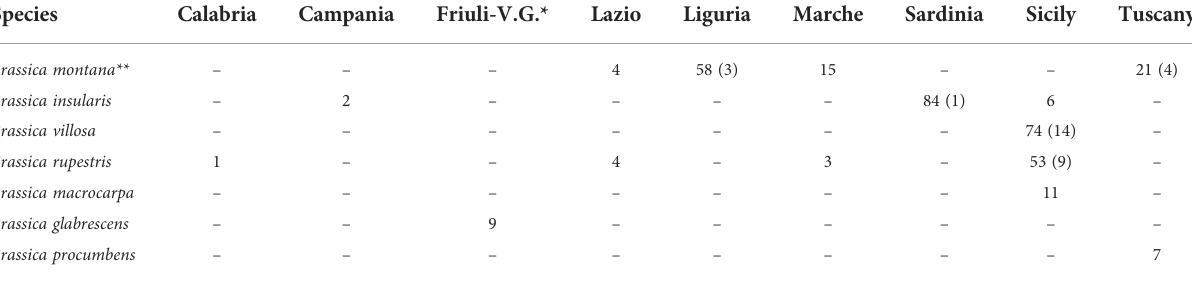
TABLE 4 Number of in situ and ex situ (in bracket) populations of the different CWR species belonging to the genus Brassica in the different Italian regions of occurrence. Species